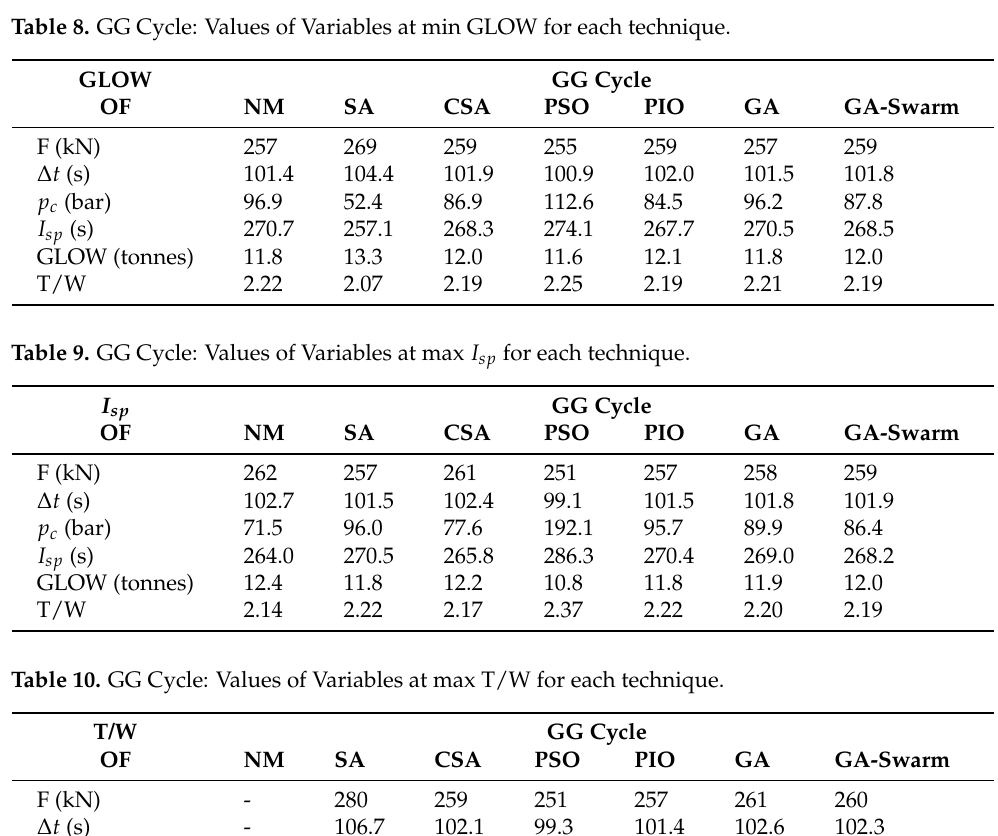
Table 8. GG Cycle: Values of Variables at min GLOW for each technique. GLOW OF